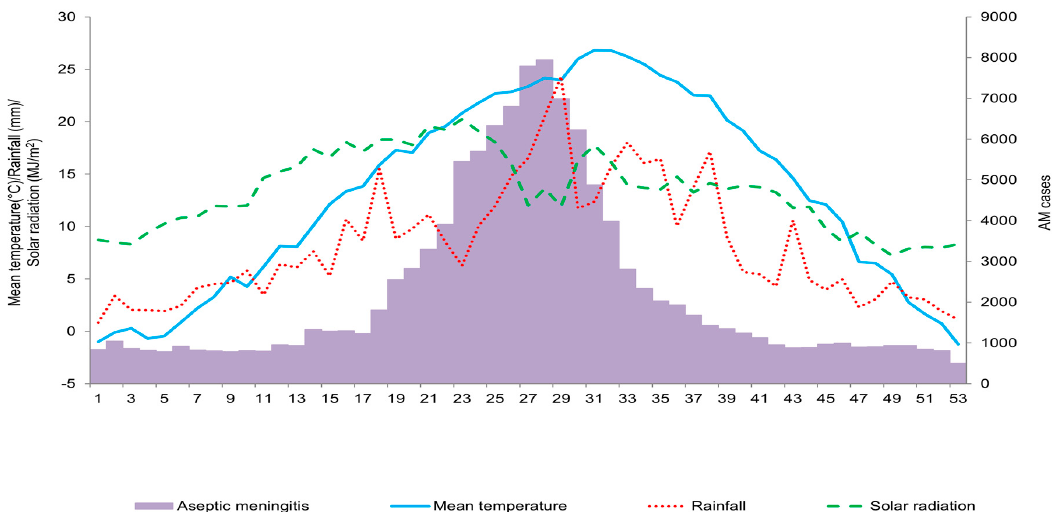
Figure 3. Weekly distribution of aseptic meningitis cases with local climate factors in six metropolitan provinces of Korea. The figure indicates weekly variation of AM cases with local climate factors among the six metropolitan provinces of Korea over the 11-year period. The highest weekly prevalence is found in the 28th week.